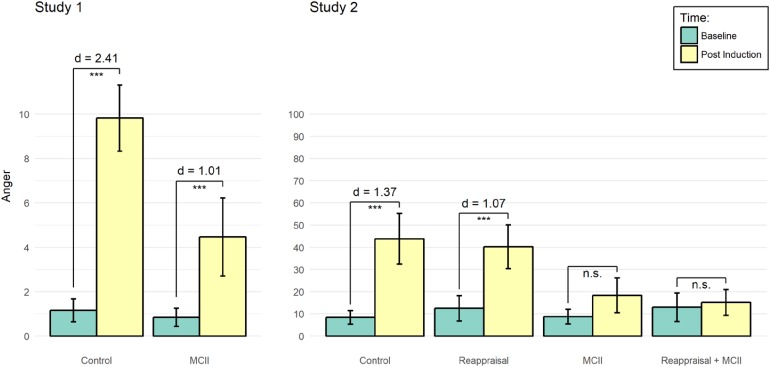
Mean ratings of reported anger by conditions at baseline and post induction, separately for Studies 1 and 2. Error bars represent 95% confidence intervals. ∗∗∗p < 0.01.